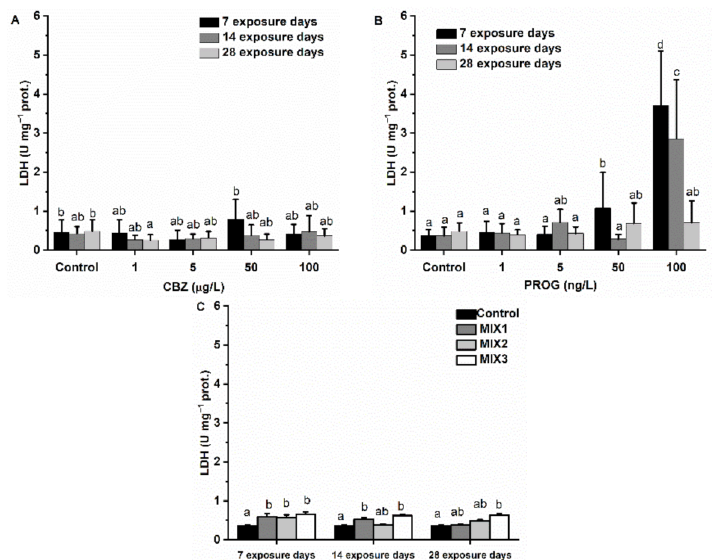
Figure 10. Changes in LDH activity in the liver of Danio rerio exposed to ( A ) CBZ, (B ) P4, and ( C ) binary mixtures of CBZ and P4 for 7, 14, and 28 days. Data are expressed as mean ± standard deviation of fifteen replicates ( n = 15). Different letters indicate significant differences at p < 0.05 after a two-way ANOVA followed by Tukey’s post hoc